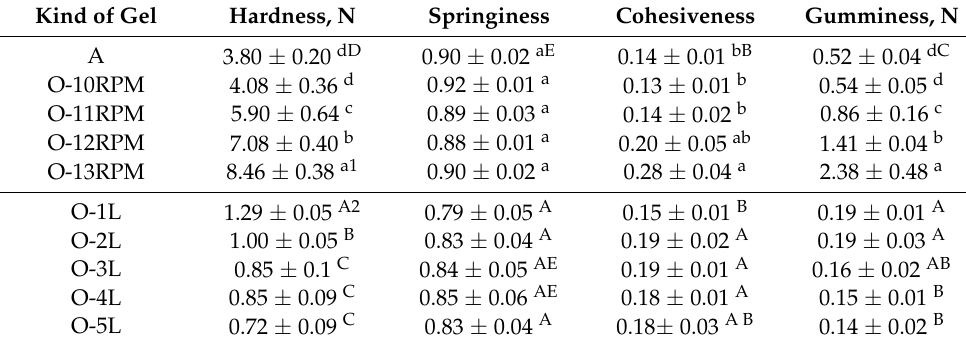
Table 2. TPA parameters of different